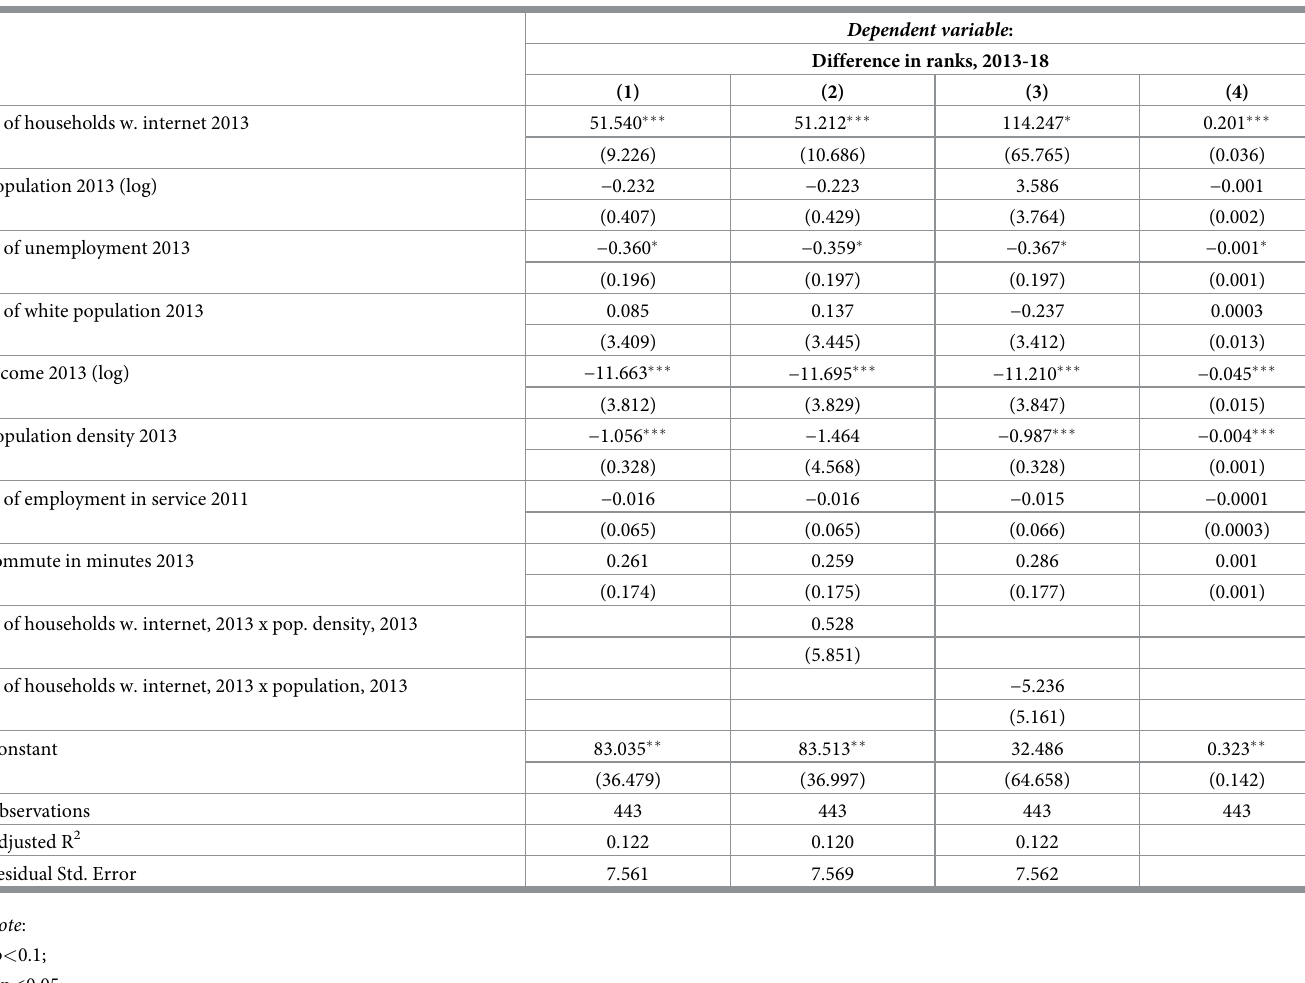
Table 7. OLS and GLM estimations of Eq (4) for